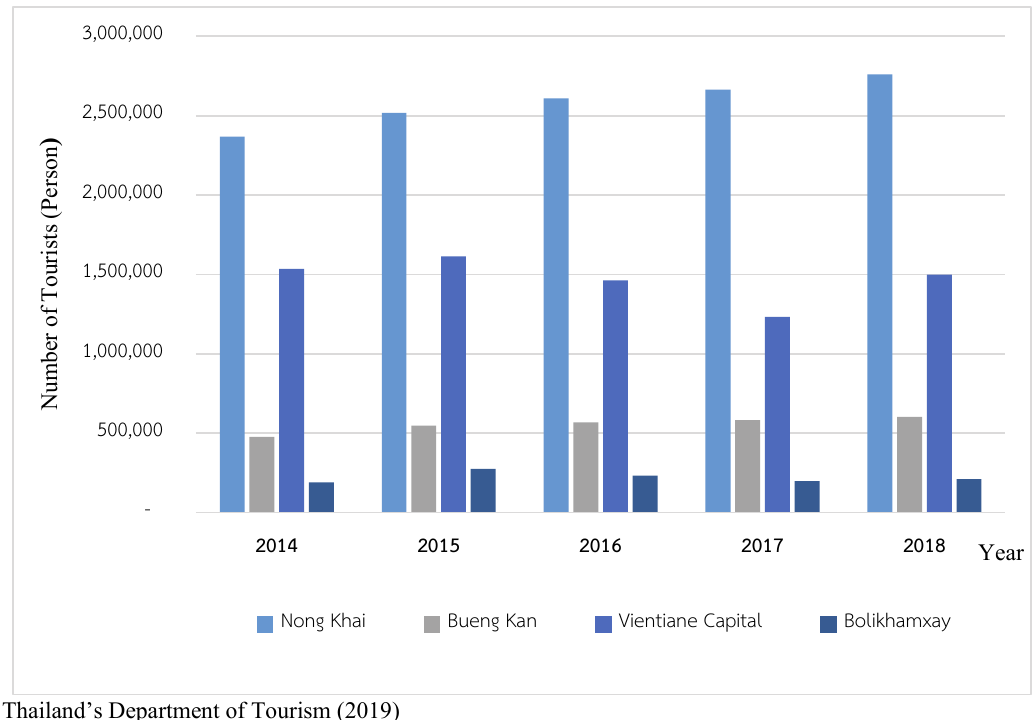
Fig. 1. Number of Thai and foreign tourists who visited Nong Khai, Bueng Kan, Vientiane Capital, and